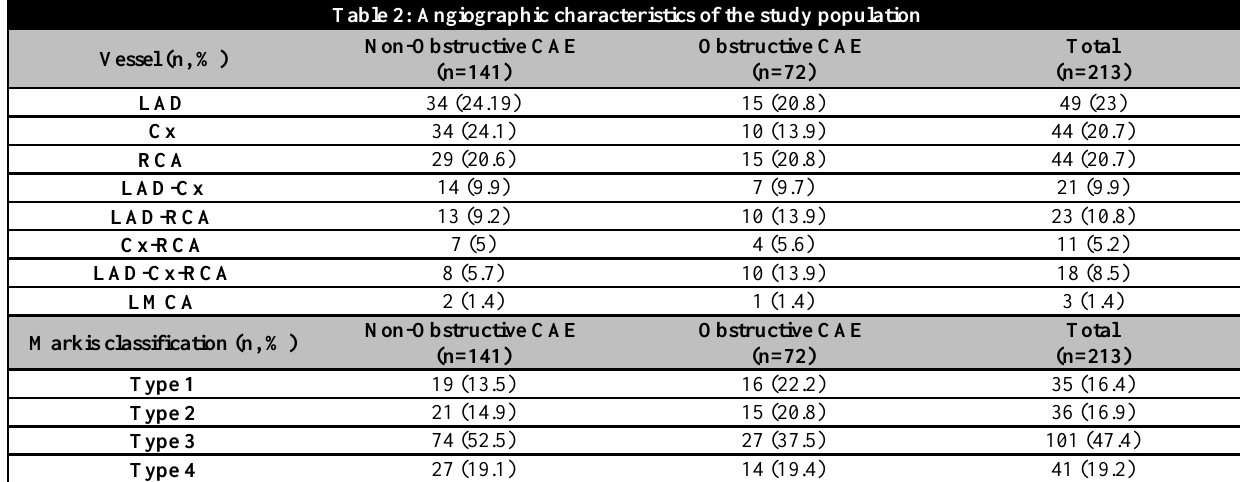
Table 2: Angiographic characteristics of the study population Vessel (n, %)